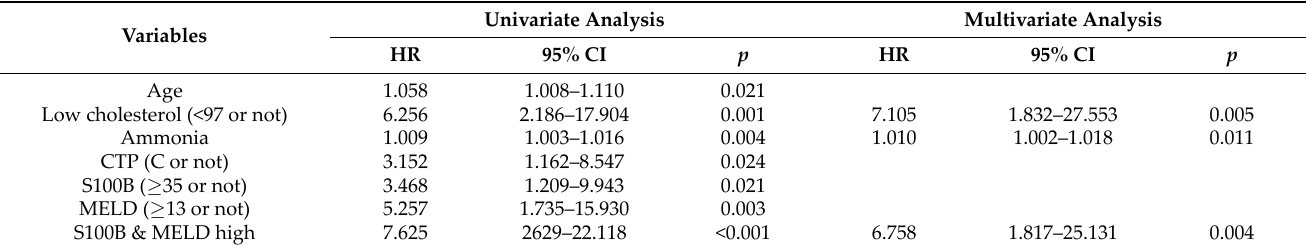
Table 7. Univariate and multivariate Cox analyses for predicting 1‑year